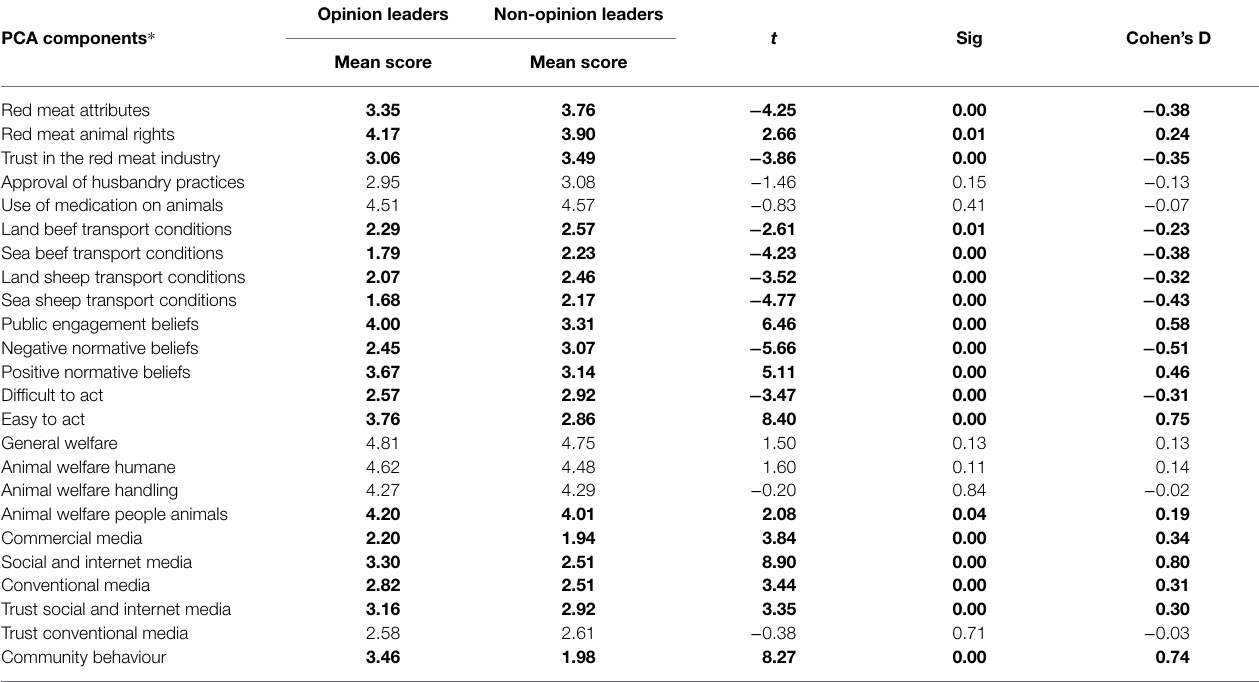
* Label definitions – see Table 1 for details. Values highlighted in the table are statistically